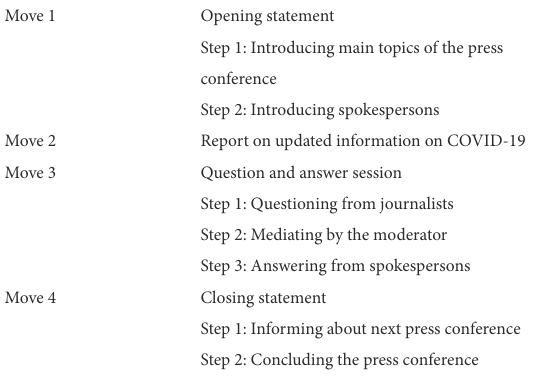
TABLE 1 Generic structure of press conferences on COVID-19 in China.